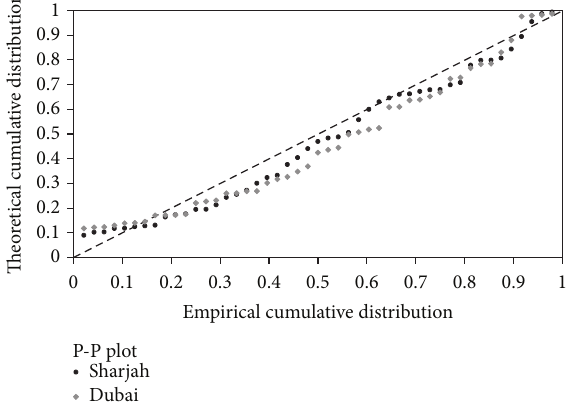
Figure 2: Cumulative probability distribution of Sharjah versus